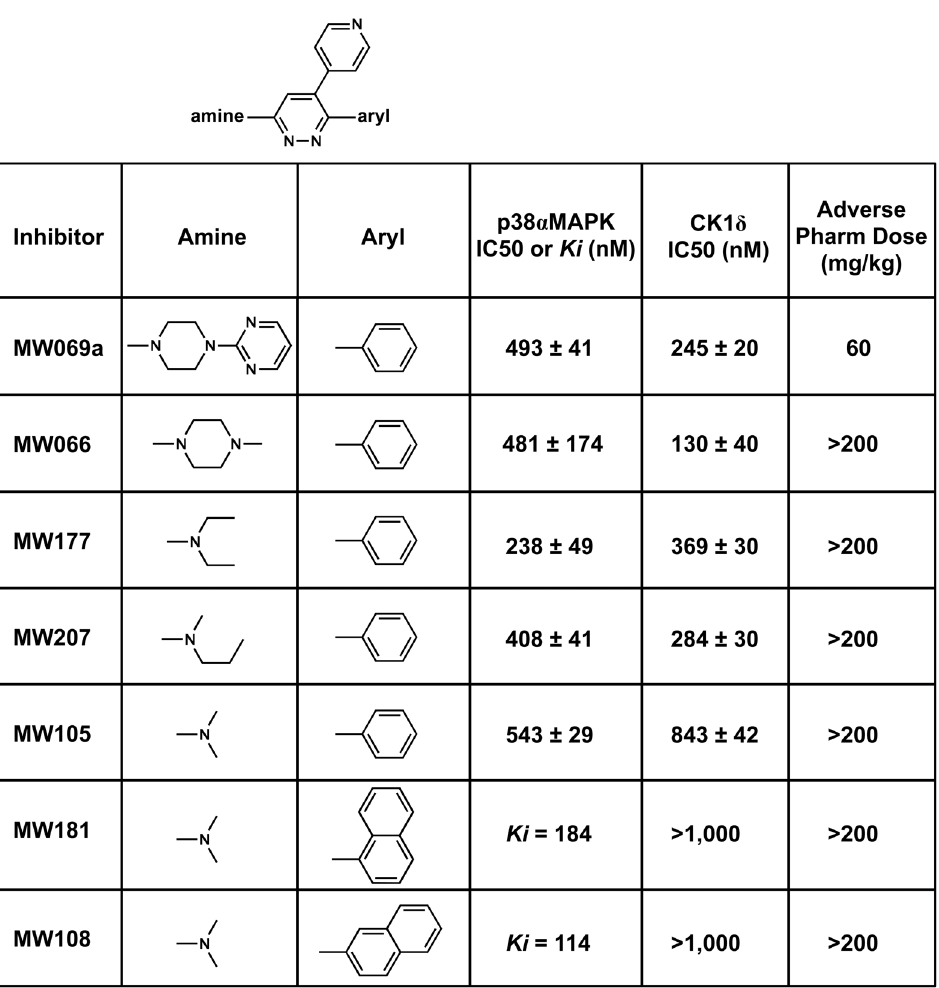
Figure 3. Synthesis of p38 a MAPK inhibitor analogs and initial screens for differential p38 a MAPK vs CK1 d inhibition and for improvement in high dose tolerance. The affinity of compounds for p38 a MAPK and CK1 d is shown, as well as the highest dose at which no adverse events are observed in dose escalation studies.